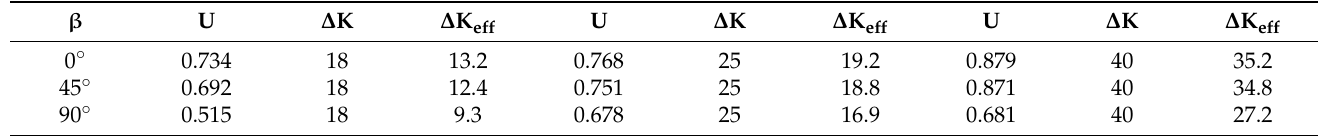
Observing the U values and the respective ∆ K values in Table 2, it is possible to realize that the crack closure induced by oxides is more pronounced for lower values of ∆ K due to the longest action time of corrosion which allows a larger oxide formation, and given that, for lower ∆ K, the crack tip opening is low, both phenomena lead a high interaction between the fracture surfaces and the oxides, thus obtaining a lower FCGR speed (see Figure 7). When the ∆ K increases, these phenomena suffer from a reduction in the stabilization phase, with the FCGR rate becoming higher and at an almost constant slope. Moreover, the behavior described previously was more evident in the samples produced with β = 90 ◦ , with a decrease of these phenomena with the decreasing of martensite amount observed in each series. Finally, it can be said that saline corrosion produced, in these cases, a reduction of FCGR speed due to the emergence of a high level of crack closure induced by oxides allied to the crack closure induced by plasticity in the crack tip when compared with the FCGR tests performed without saline corrosion where the crack closure levels were attributed